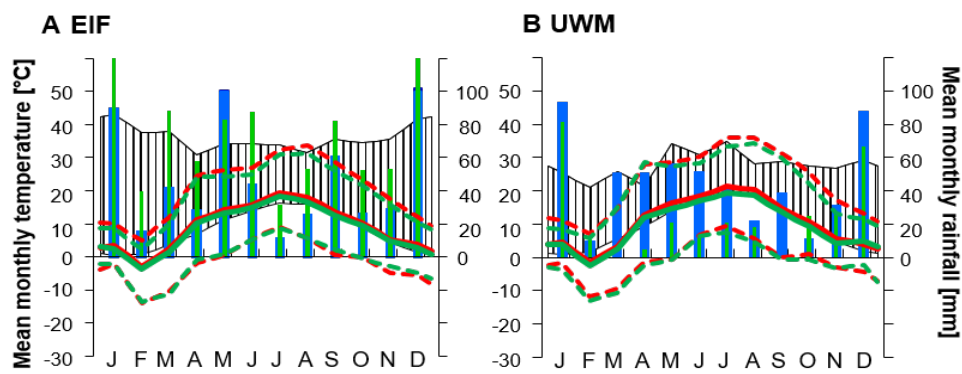
Figure 1. The monthly mean, maximum, and minimum air temperatures (green solid and dashed lines) and monthly precipitation sums (green bares) for 2018 measured at the Eifel (A, EIF) and Marburg university forest (B, UWM) research sites. In addition, data from nearby DWD stations (Kall–Sistig for EIF and Gießen–Wettenberg for UWM) is presented for comparison. For 2018, the temperature and precipitation data is presented as red lines and blue bars, while the long–term data (1981–2010) is presented with the mean monthly precipitation (upper black lines), mean monthly temperatures (lower black lines), and months with humid conditions (black striped areas). Table 2. Comparison of the mean temperatures and precipitation totals in both research sites for various time periods and climate stations. EIF UWM Temp. Time Period